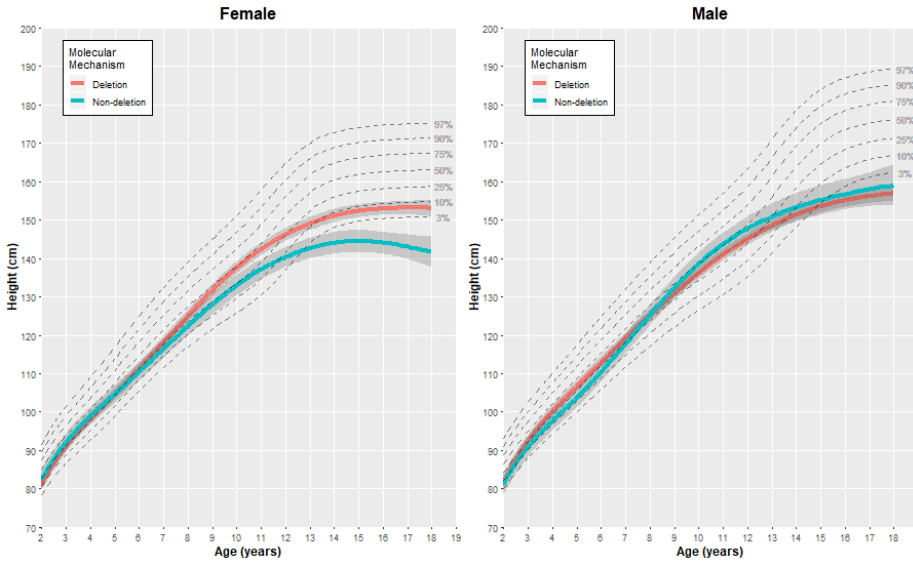
Figure 2. Estimated growth curves for the height of individuals with the deletion and non-deletion mechanism causing PWS in our study cohort (colored lines), alongside the normative percentile ranges of height growth (dashed gray lines).